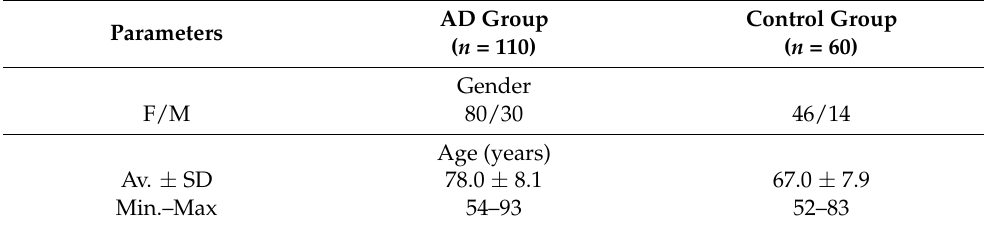
Table 1. Characteristic of study